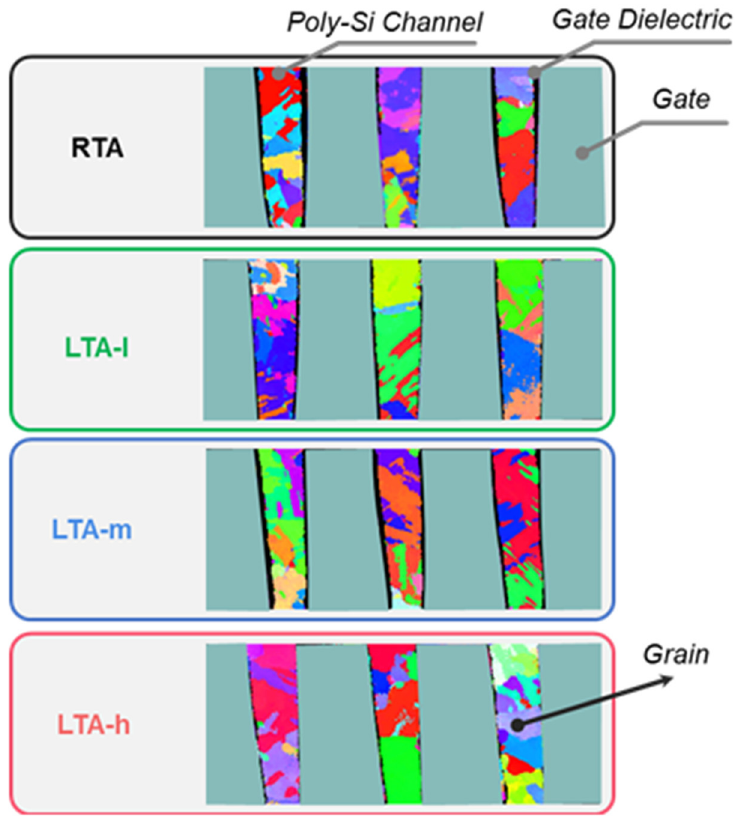
Figure 4. The PED graphs of the cross ‐ section view of Poly ‐ Si with different thermal conditions, RTA, LTA ‐ l, LTA ‐ m, and LTA ‐ h.